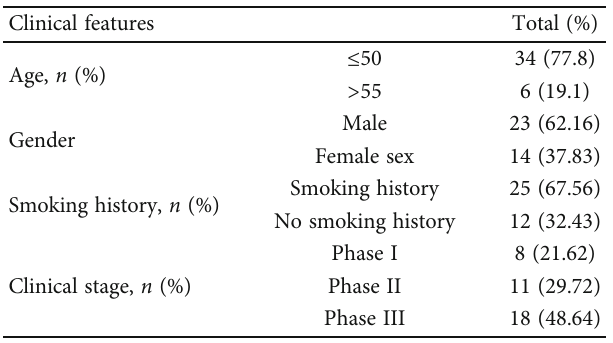
Table 1: Analysis of clinical characteristics and causes of pulmonary nodules (data source: self-statistics of the study).